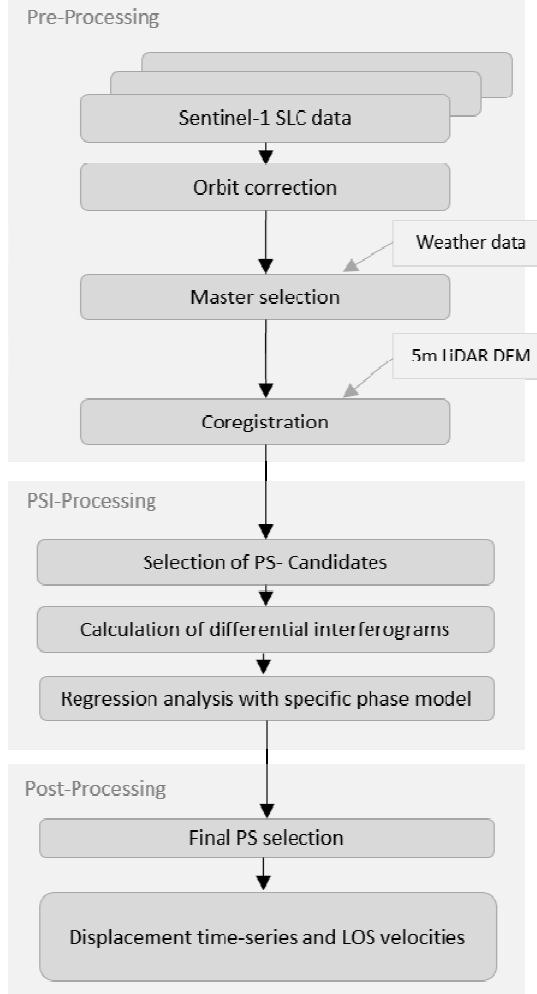
Figure 2: Workflow of the